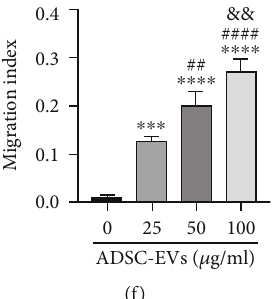
Figure 6: ADSC-EVs signi fi cantly promote the proliferation and migration of RPMCs in a dose-dependent manner. (a, b) E ff ect of di ff erent concentrations of ADSC-EVs on the proliferation of cells by EdU assays. The migration ability of RPMCs treated with ADSC-EVs, measured by (c, d) transwell and (e, f) scratch test assays. Bars, 100 μ m. Data are represented as the mean ± SD . ∗ , vs. control group; n = 3 . ∗∗∗ P < 0 : 001 . # , vs. 25 μ g/mL group; ## P < 0 : 01 and ## P < 0 : 0001 . & , vs. 50 μ g/mL group; && P < 0 : 01 and &&&& P < 0 : 0001 .